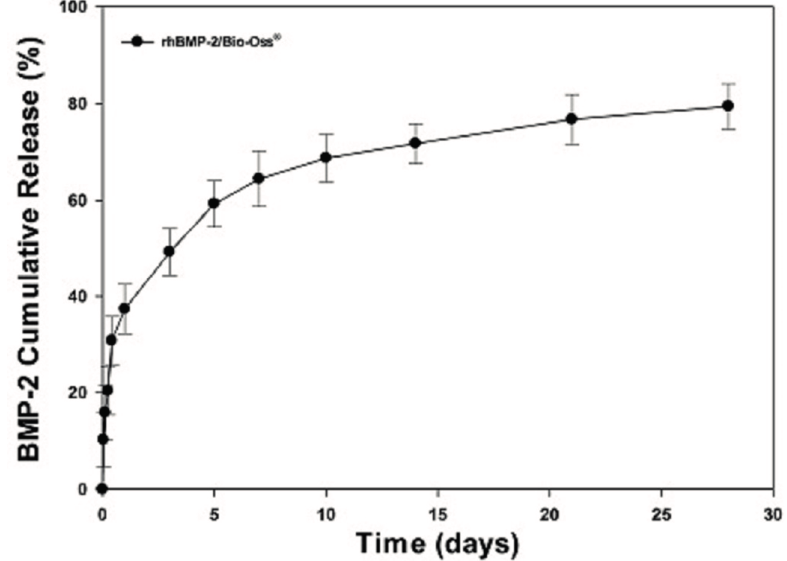
Figure 4. The in vitro release of rhBMP-2 from BMP-2/Bio-Oss ® group.